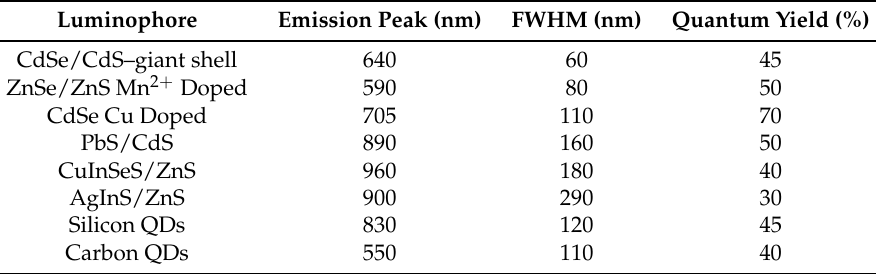
Table 2. Emission properties of luminophores.